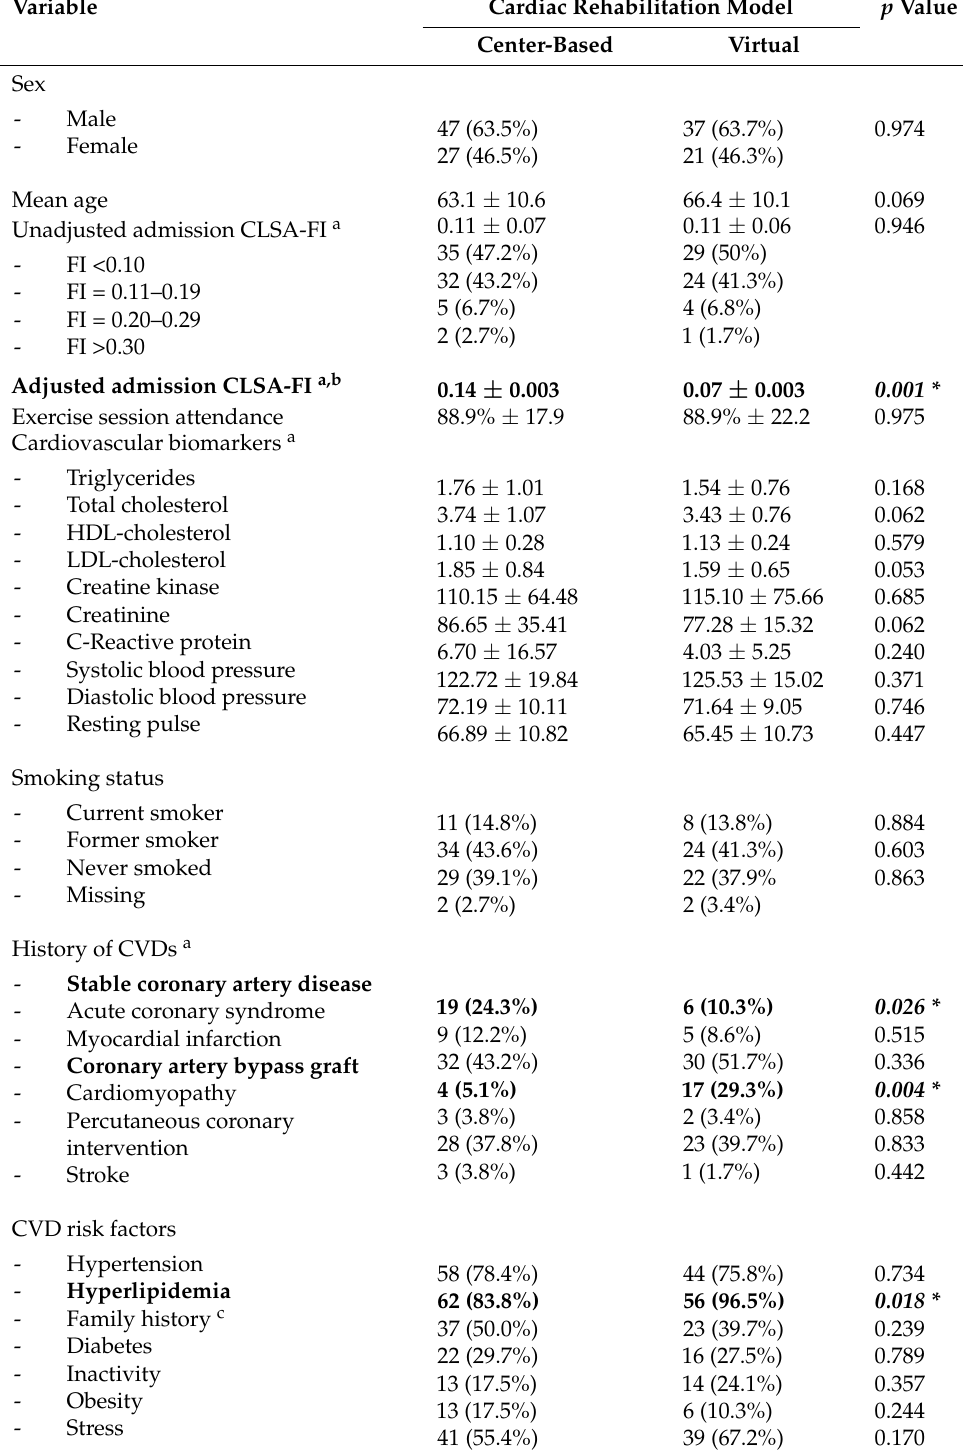
Table 1. Demographic information of center-based and virtual cardiac rehabilitation participants at CR